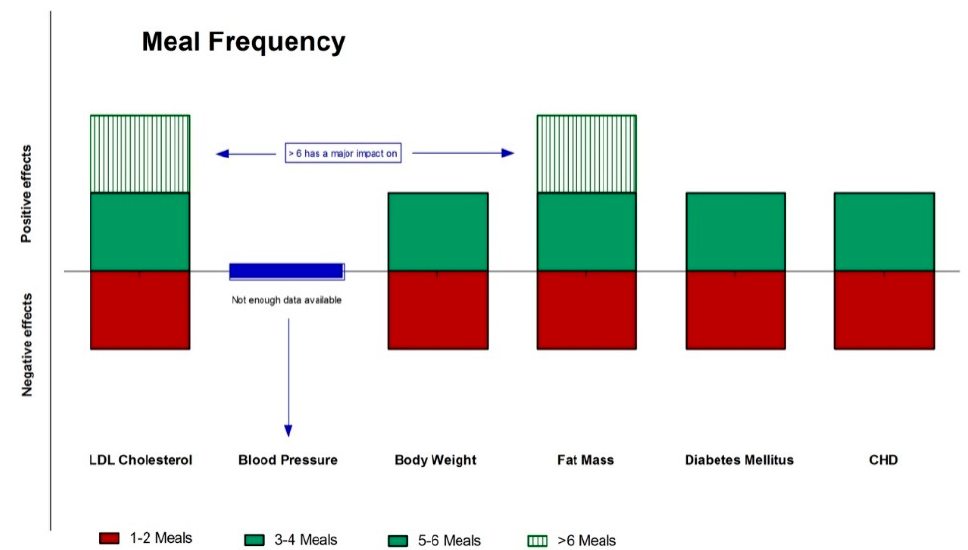
Figure 4. Effects (green: positive; red: negative; blue: neutral) of meal timing on different CVD risks factors and diseases. CHD: coronary heart disease; CVD: cardiovascular disease; TRF: time restricted feeding.